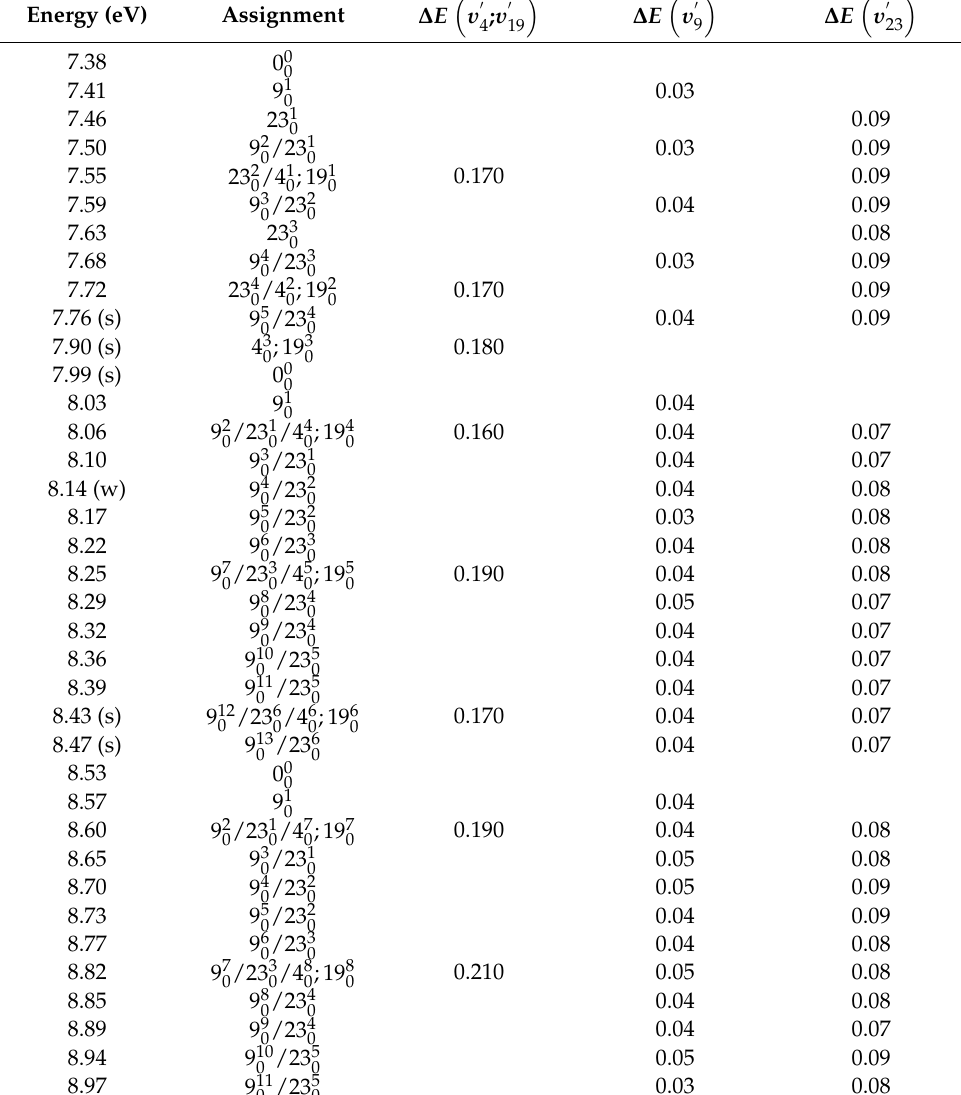
Table 5. Proposed vibrational assignments in the 7.3 − 9.0 eV absorption band of 5BrPyr (Band V). ∆ E (in eV) represents the energy of one extra quanta in the vibrational progression. The symbol “/” means both modes are involved; the symbol “;” means two alternative